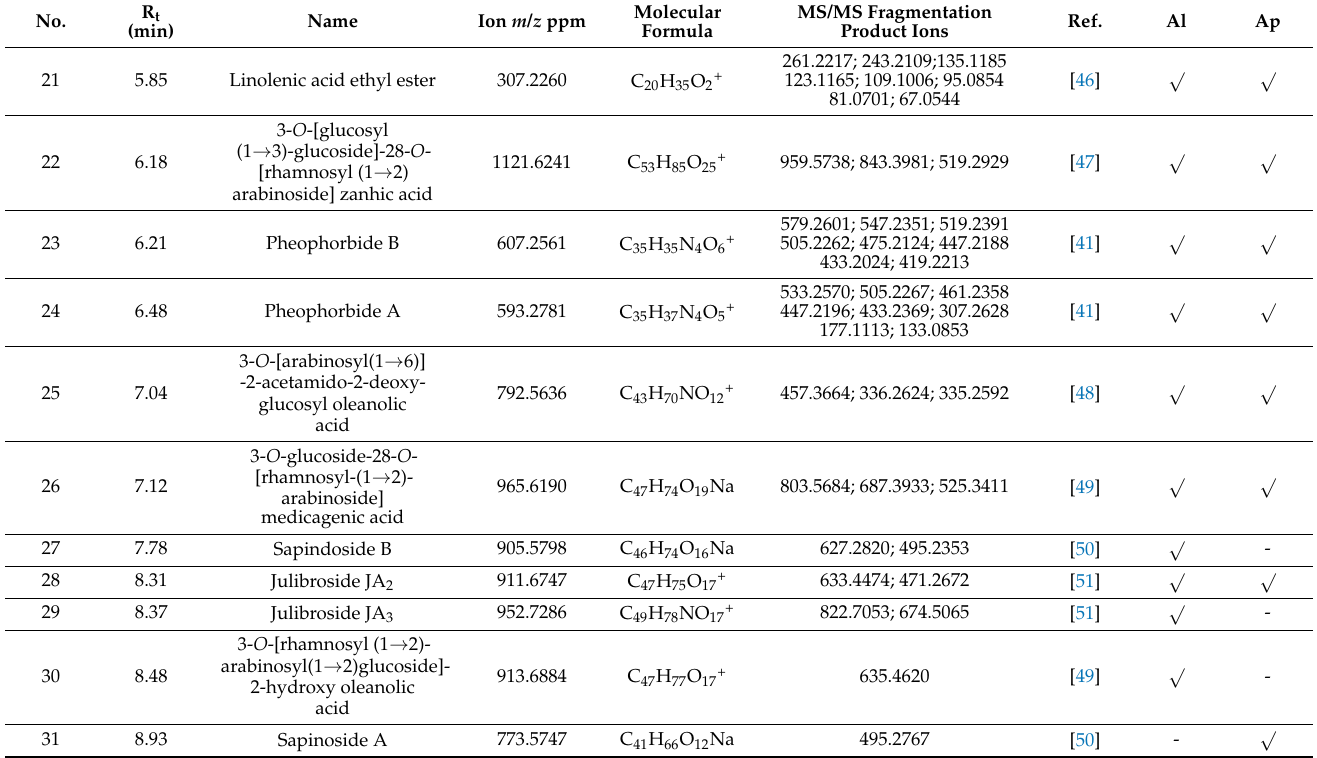
Figure 4. GNPS molecular network of different fractions of A. lucidior ethanolic extract in the posi- tive ion mode. Each node is displayed as a pie chart representing the relative abundance of the metabolite with different colors in different fractions . The node label represents precursor mass ( m / z ). The node size represents the sum of precursor ion intensity.